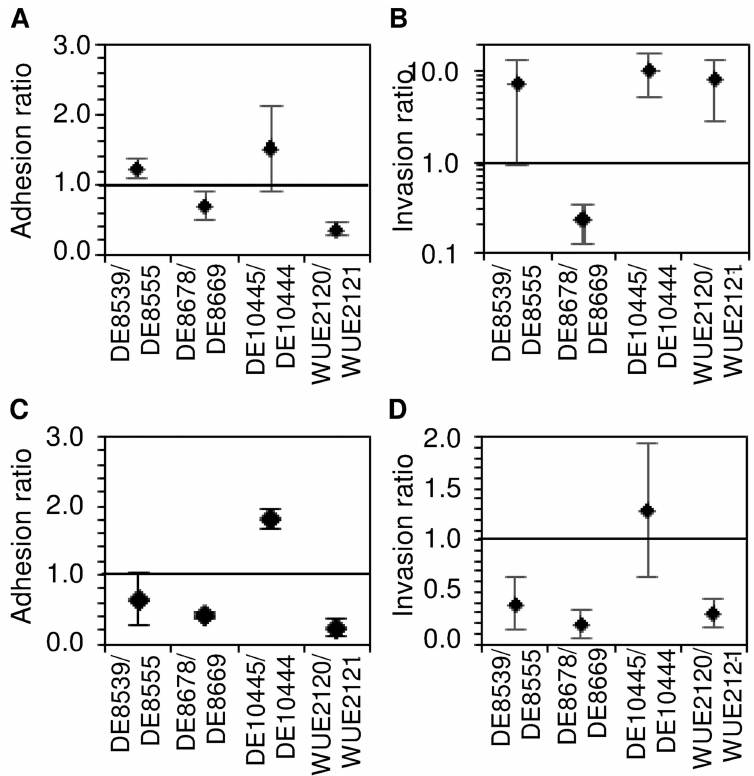
Fig 5. Comparison of the interaction of meningococci with human cells. Panels(A) and (B) comparethe interaction of meningococcal throat and blood isolates with Detroit-562epithelialcells derived from a human pharynxcarcinoma.Likewise, panels (C) and (D) compare their adhesion to and invasionof humanEAhy926 umbilicalvein endothelial cells. (A) and (C) Scatter plots of the adhesion ratios for each strain pair given as the CFU ratio of the adherentbacteriaof the blood isolate relativeto the respectivethroat isolate. Values greater (smaller) than one indicate that the blood isolates adherebetter (less) to humancells than the corresponding throat isolate. (B) and (D) Scatter plots of the invasionratios for each strain pair given as the ratio of the invasionrate of the blood isolaterelative to the invasionrate of the correspondingthroat isolate. Values greater (smaller) than one indicate that the blood isolates are more invasivethan the corresponding throat isolate. For each strain pair, the mean and standard deviationof three independentexperiments are